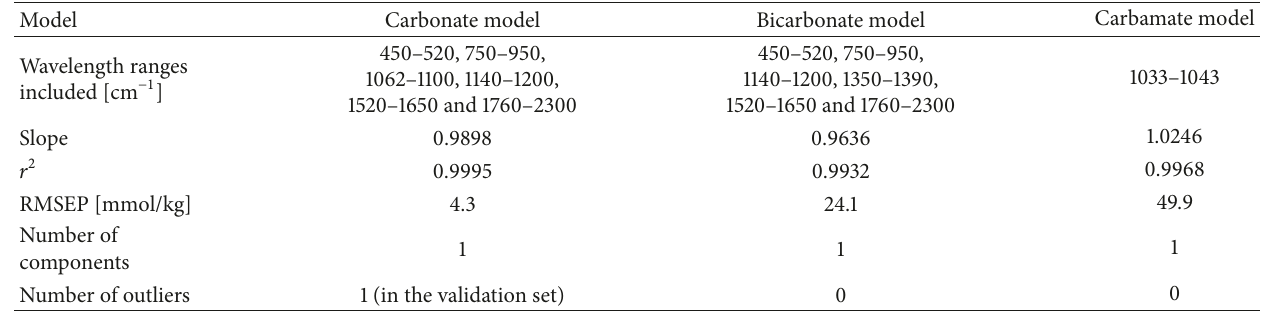
Table 3: PLS-R modeling of carbonate, bicarbonate, and